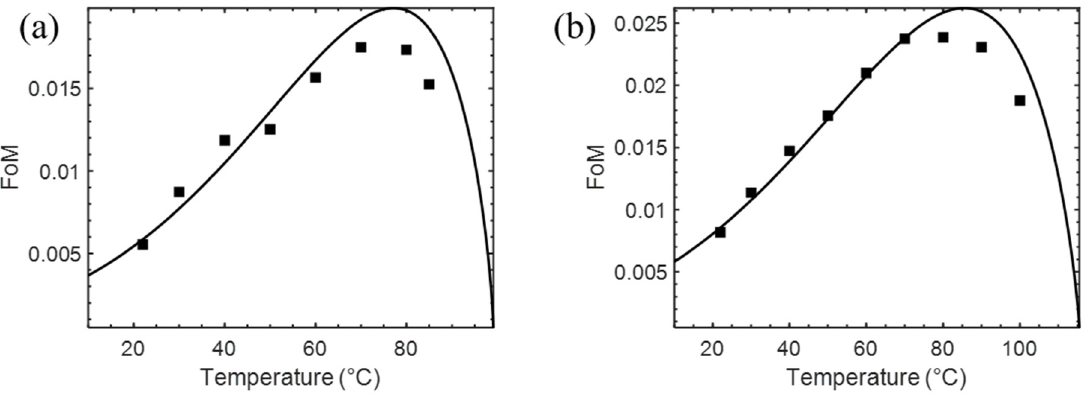
Figure 6. Temperature-dependent FoM of ( a ) LCM-1107 and ( b ) LCM-2018. Squares are measured data and solid lines are fitting curves. Table 2. Fitting parameters obtained through Equations (1)–(3).